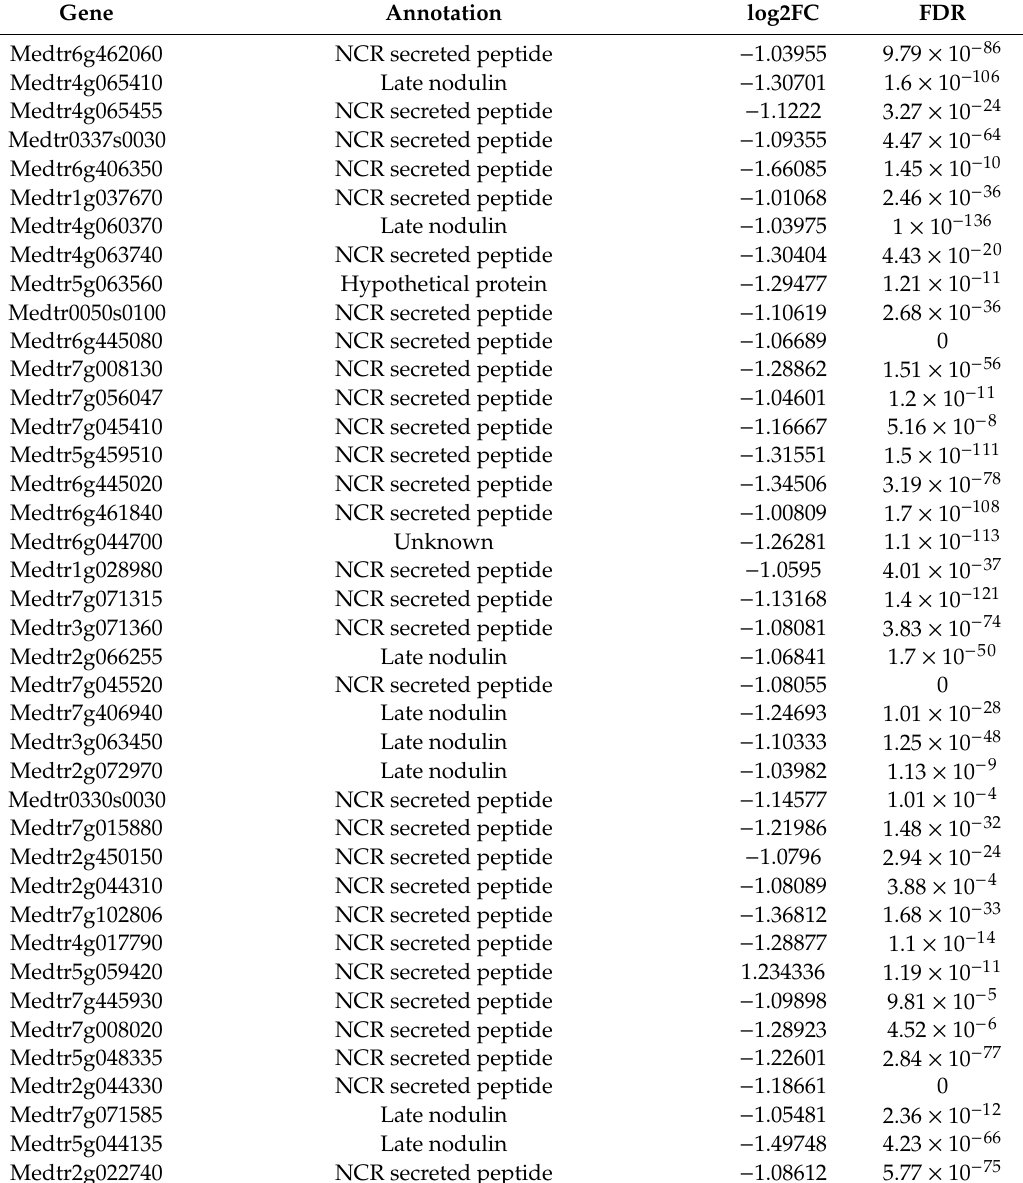
Table 2. The expression of genes involved in GO:0009878. FDR—false discovery rate.